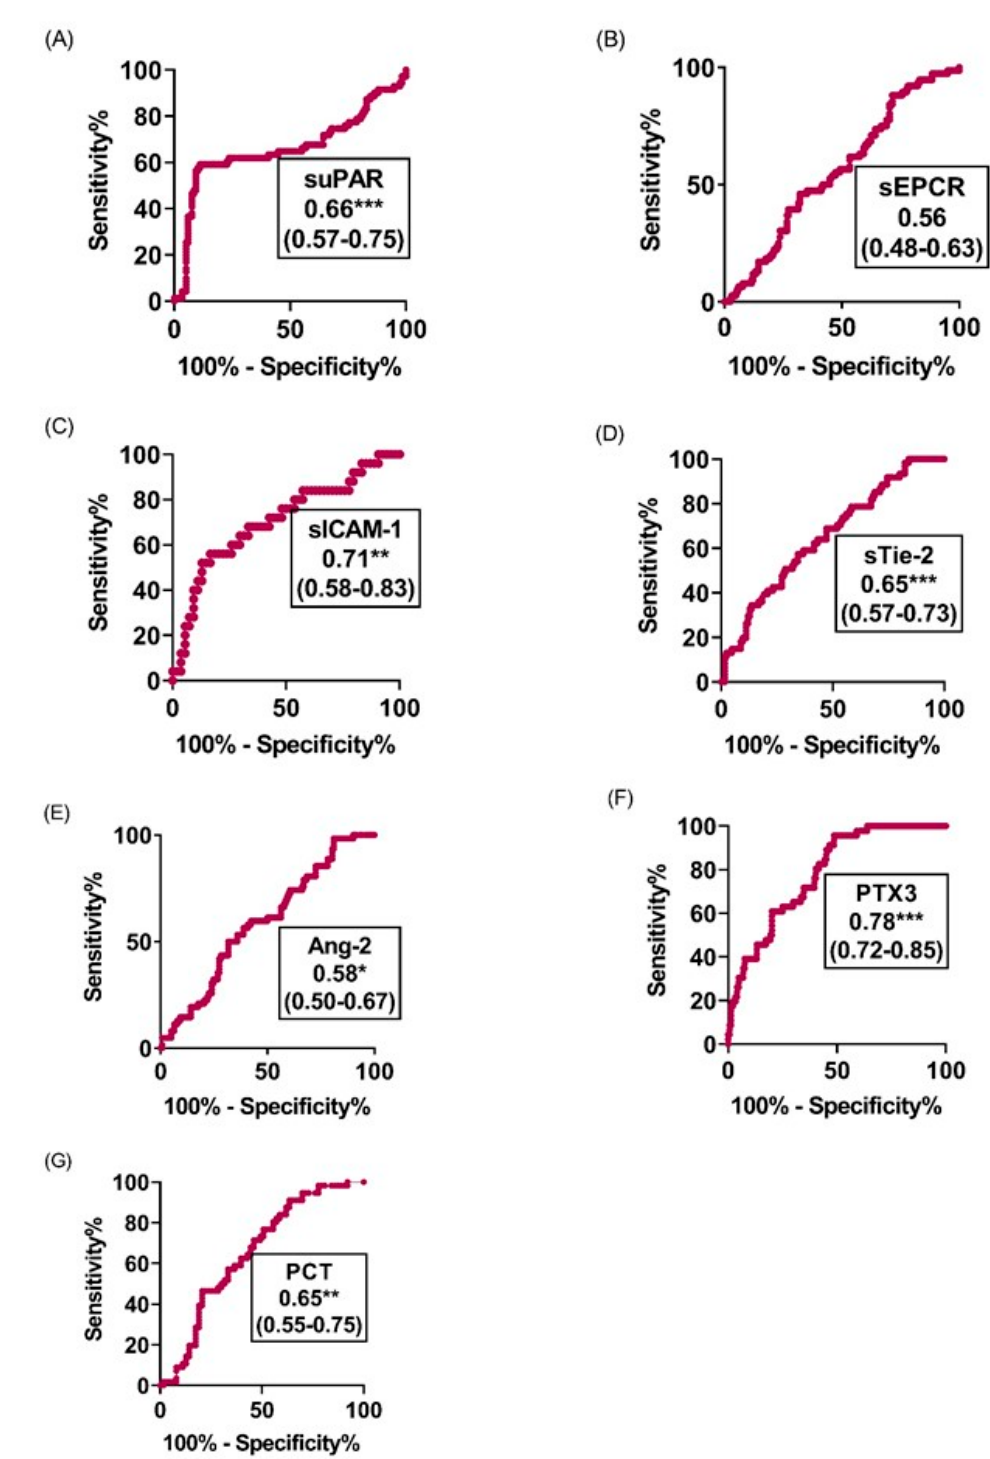
Figure 5. ROC curve analyses of the individual prediction performance of PTX3, sICAM-1, suPAR, sTie-2, PCT, Ang-2 and sEPCR to differentiate coma (BCS < 3) from non-coma (BCS > 2) among severe cases on the day of admission to hospital. ( A – G ), Assessment by ROC curve analyses of the individual prediction performance of ( A ) suPAR, ( B ) sEPCR, ( C ) sICAM-1, ( D ) sTie-2, ( E ) Ang-2, ( F ) PTX3 and ( G ) PCT to differentiate patients with deep coma cases (BCS < 3) from those without coma (BCS > 2) among severe cases diagnosed on the day of admission to hospital. The area under the curve as well as the confidence intervals are indicated in the legend. The * indicates 0.01 < p value <0.05, ** 0.001 < p value <0.01, *** indicates p value ≤ 0.001.